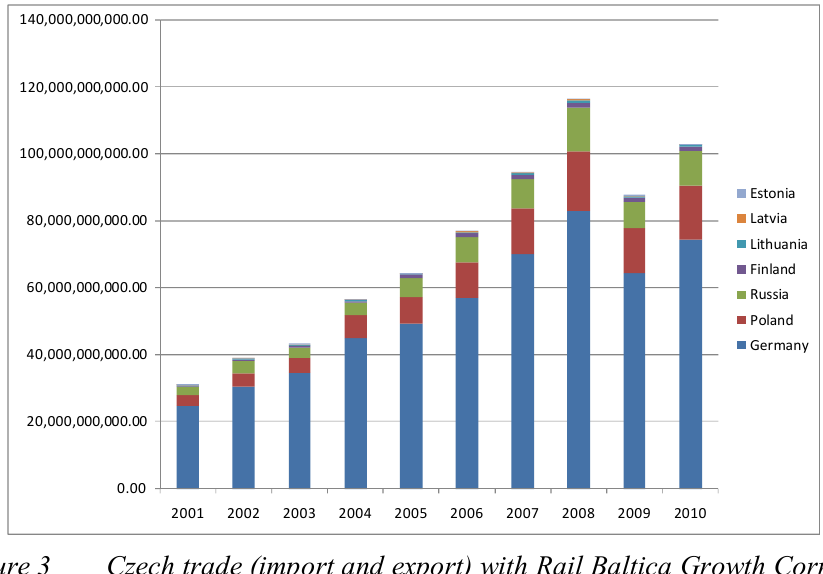
Figure 3 Czech trade (import and export) with Rail Baltica Growth Corridor countries during period of 2001-2010. Source: United Nations (2011)